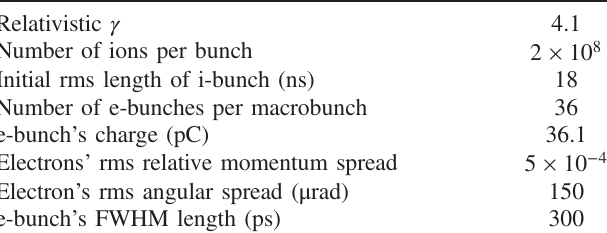
TABLE I. Beam parameters in CA